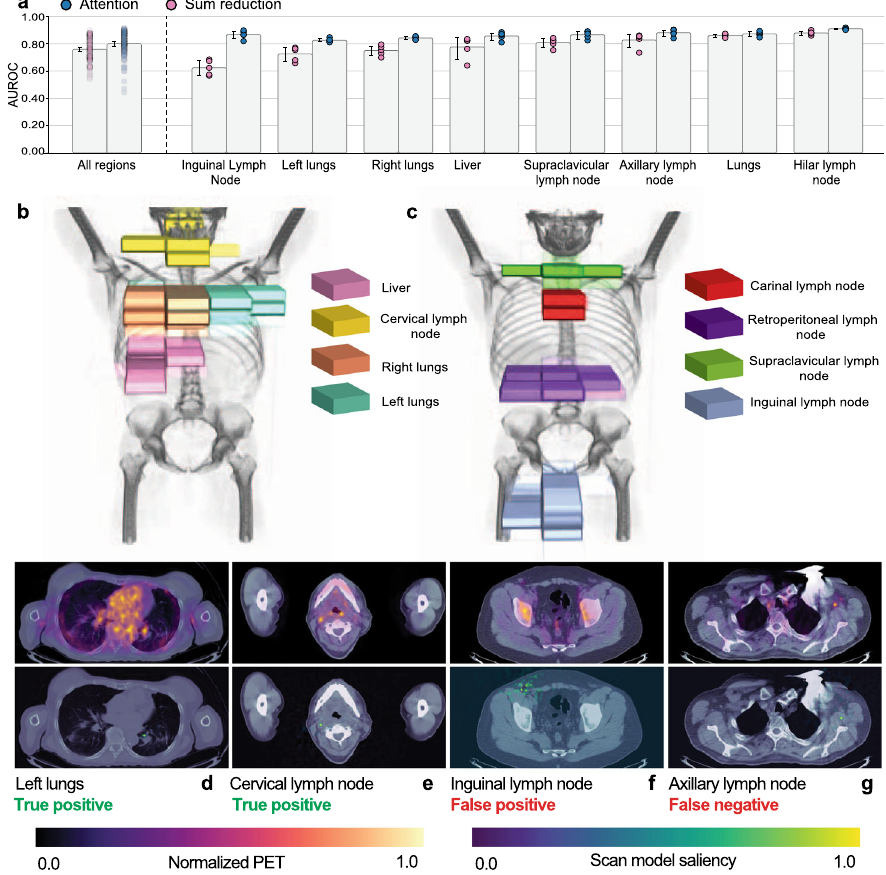
mechanism see a modest improvement over a naive sum reduction, with a 3 point increase in mean AUROC taken over all tasks and all seeds ( p = 0.0002 regions. Con fi dence intervals (95%) about the mean were determined using bootstrapping across n = 5 random seeds. b , c The soft-attention